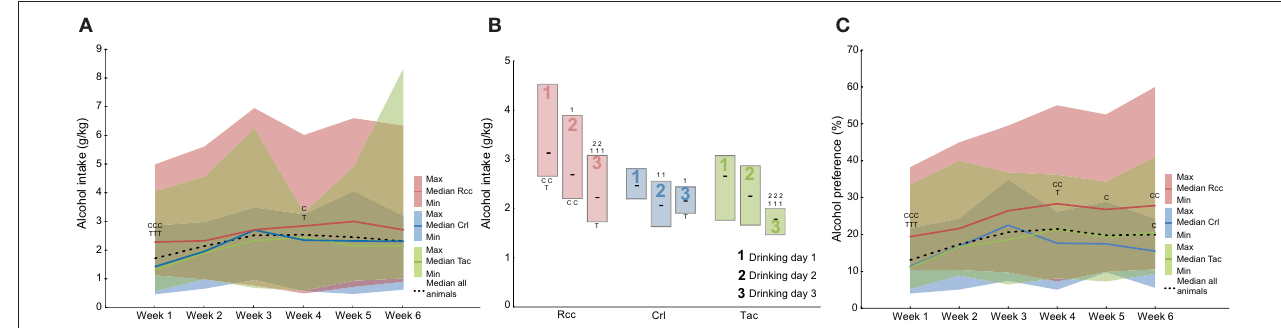
TABLE 1 | Formation of subgroups.